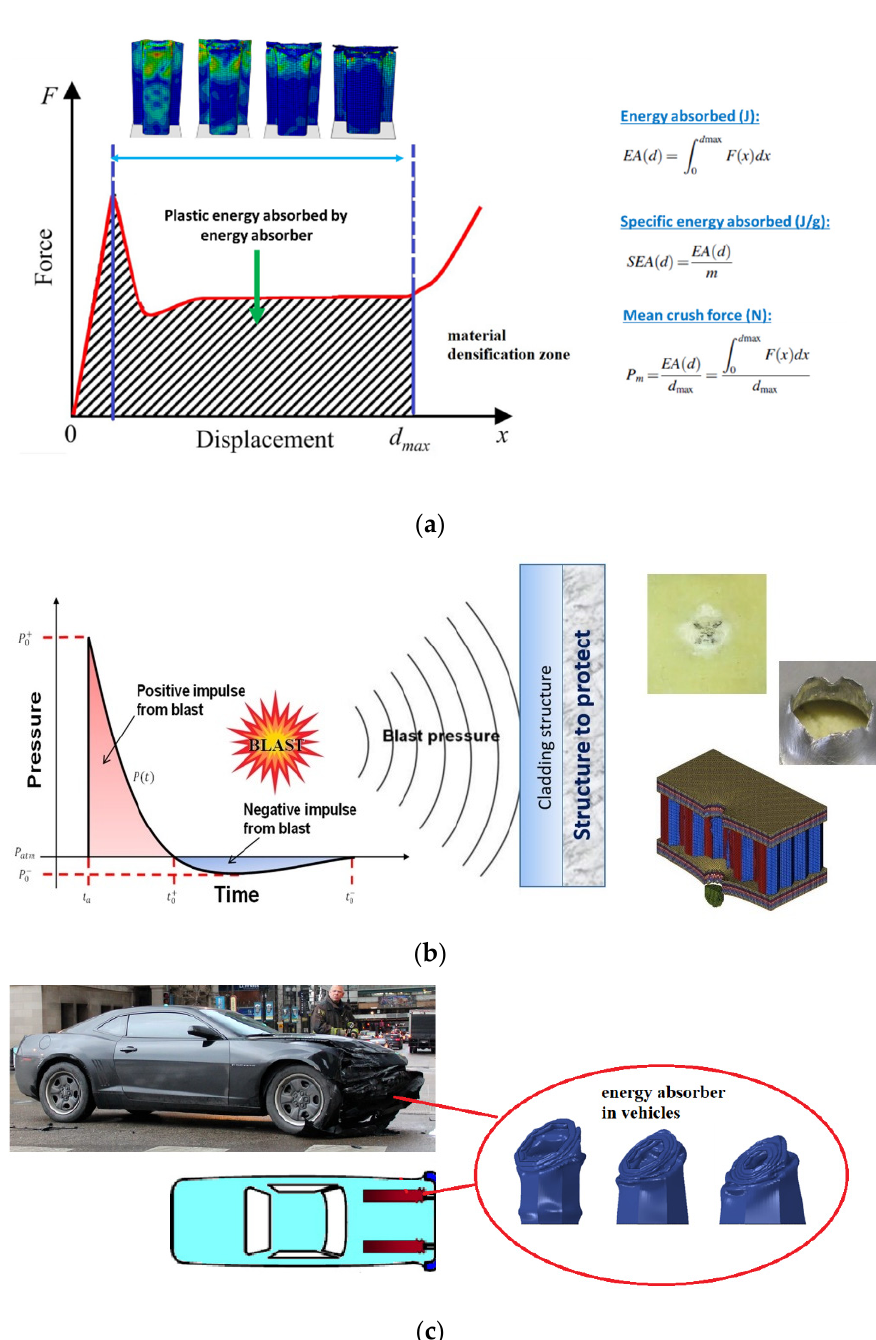
Figure 1. ( a ) General energy absorption through deformation of energy absorbers, ( b ) energy absorbers used as cladding structures for blast resistant applications and. ( c ) energy absorbers used in vehicle safety. [partial image source: “Aftermath of Car Crash on Randolph at Michigan, 21 January 2015” by danxoneil is licensed under CC BY 2.0].